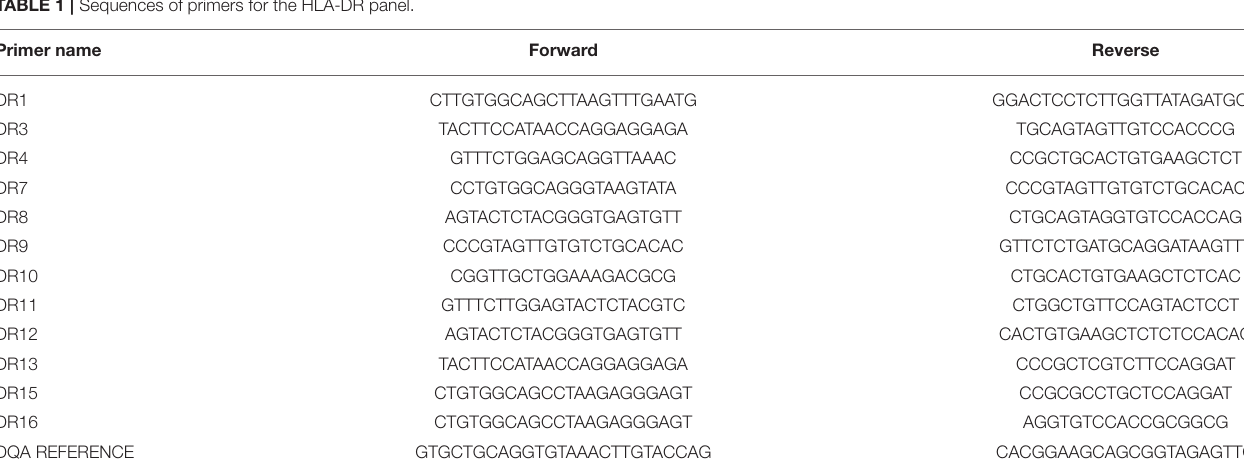
TABLE 1 | Sequences of primers for the HLA-DR